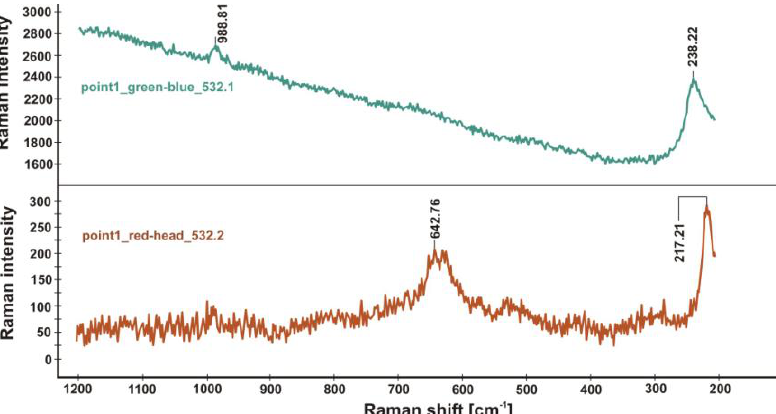
Figure 21. Raman spectra from the blue-green layer (upper plot) and red-brown layer (lower plot) shown in Figure 18, indicating the presence of antlerite (988.81 cm −1 ), cuprite (217.21 cm −1 ) and probably silver oxide Ag O (238.22 cm −1 ) [19]. 2